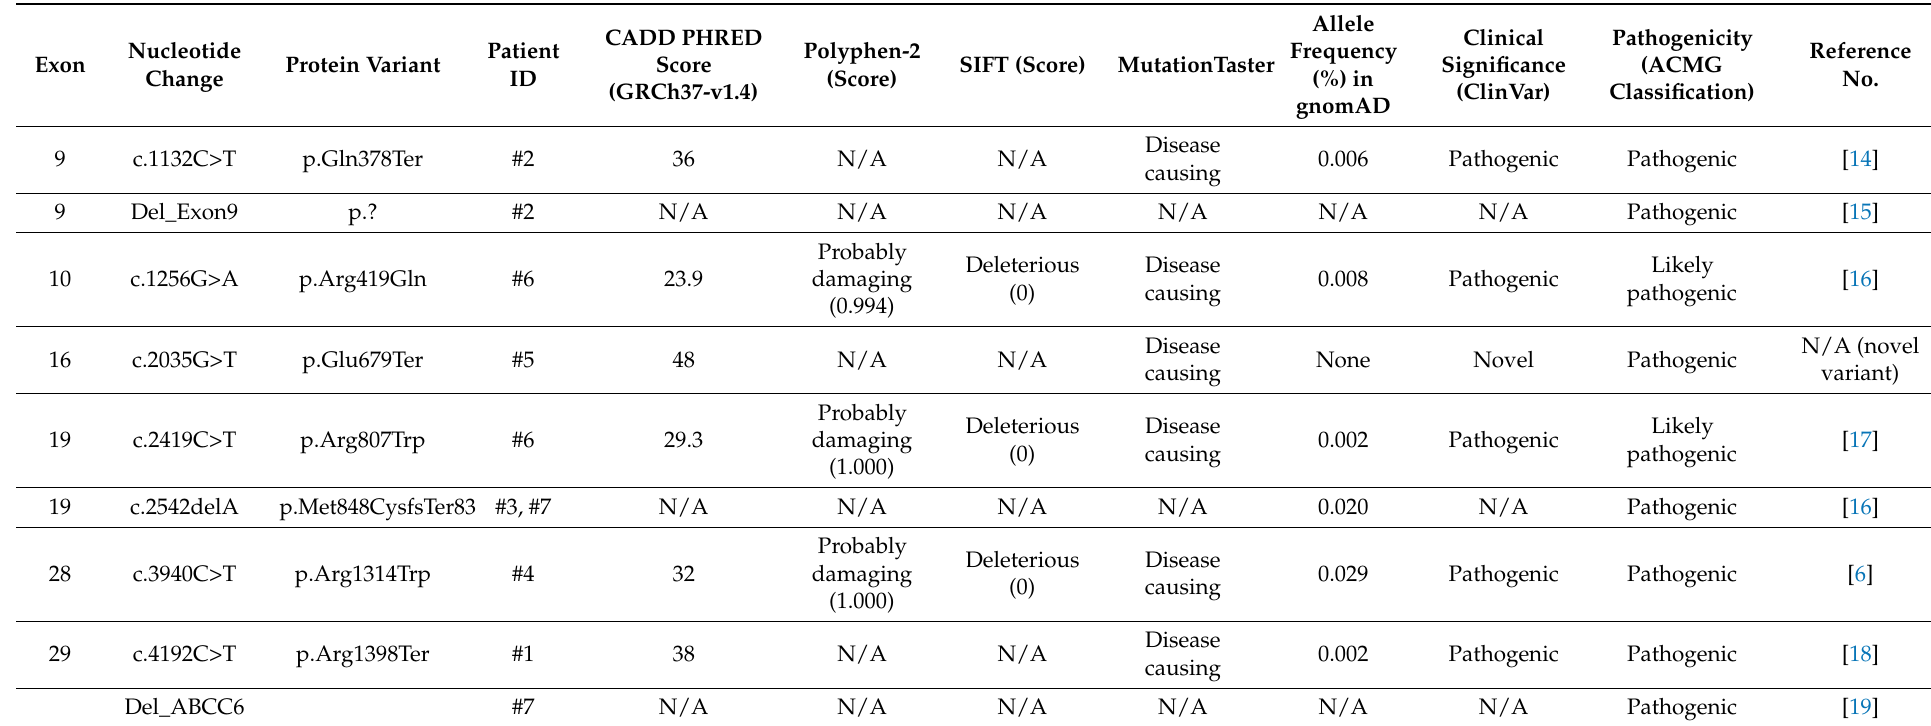
Table 2. Profiles of variants in the ABCC6 gene of